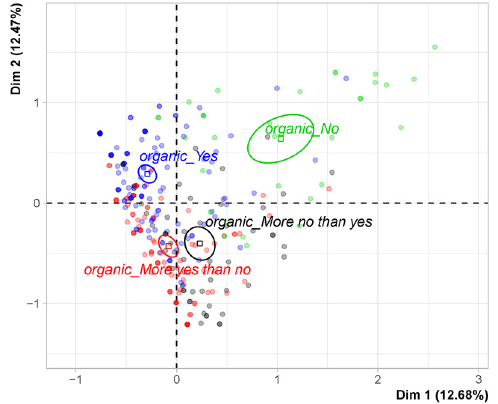
Figure A8. MCA. Distribution of respondents by attitudes towards organic structures.